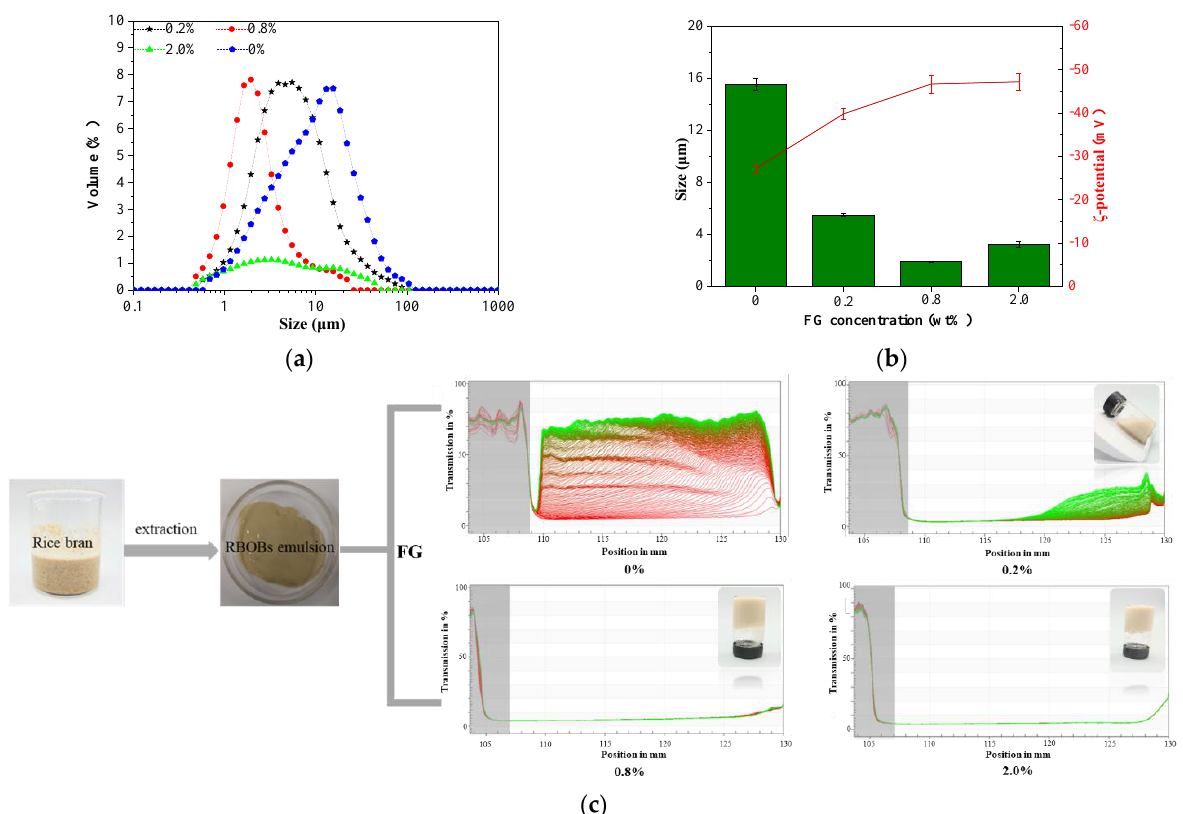
Figure 1. Particle size distribution ( a ), ζ -potential ( b ), and stability analysis ( c ) of the RBOB-FG emulsion-filled gels with varying FG concentrations dispersed in 5.0 wt.% RBOB emulsion. The ζ -potentials of RBOB-FG emulsion-filled gels are displayed in Figure 1b. As shown, the ζ -potential decreased from about − 27 mV to − 47 mV for RBOB-FG emulsion- filled gel with increased FG concentration. After the FG concentration reached 0.8 wt.%, the ζ -potential did not differ significantly, indicating that about 0.8 wt.% FG-stabilized RBOBs droplets had sufficiently negative charges, increasing the electrostatic repulsion between droplets, as proven by physical stability (Figure 1c). After all samples were processed by a LUMiSizer, obvious stratification and sedimentation were observed in RBOB emulsions. Profiles lay at the bottom, indicated as red, and the final profiles lay at the top, indicated as green [25]. Emulsion particles move individually at different speeds. The profiles were closely spaced with considerably shorter distances. A diffuse sedimentation